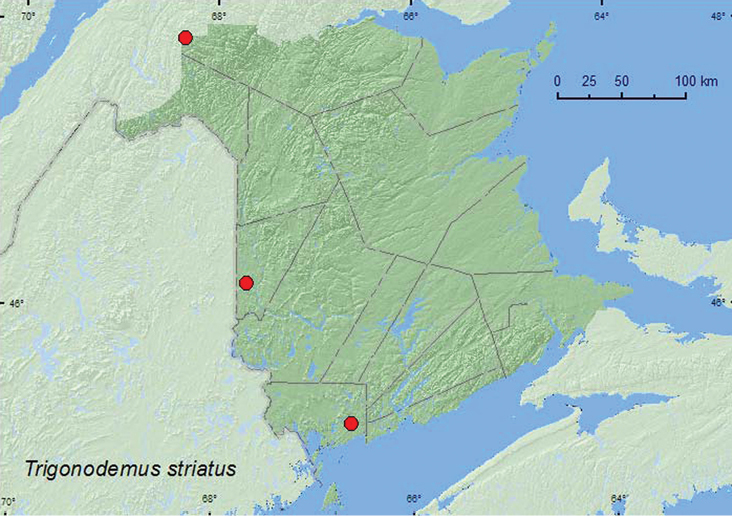
Collection localities in New Brunswick, Canada of Trigonodemus striatus.